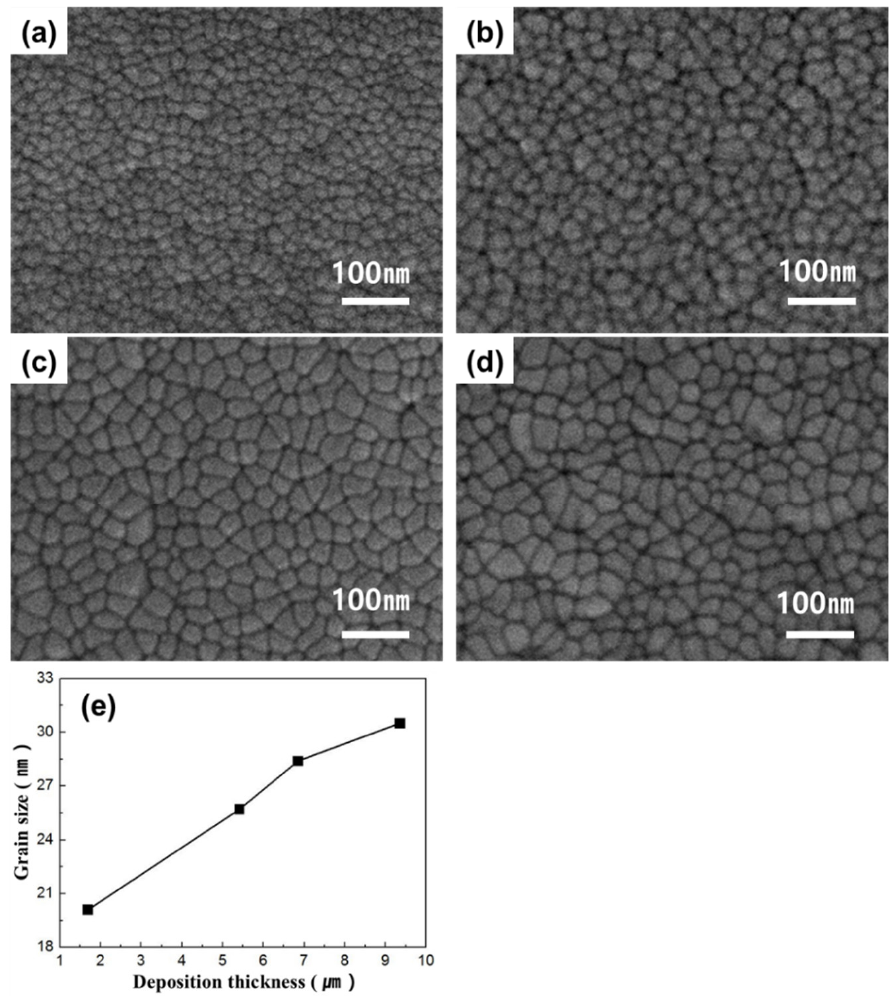
Figure 3. FE-SEM images of Ti-50.0 ± 0.3Ni (at %) thin film with film thickness values of ( a ) 1.69 μm, ( b ) 5.41 μm, ( c ) 6.85 μm, and ( d ) 9.35 μm; and ( e ) relationship between grain size and film thickness. (Deposition condition: growth rate (6.29 nm/min), substrate temperature (293 K)).